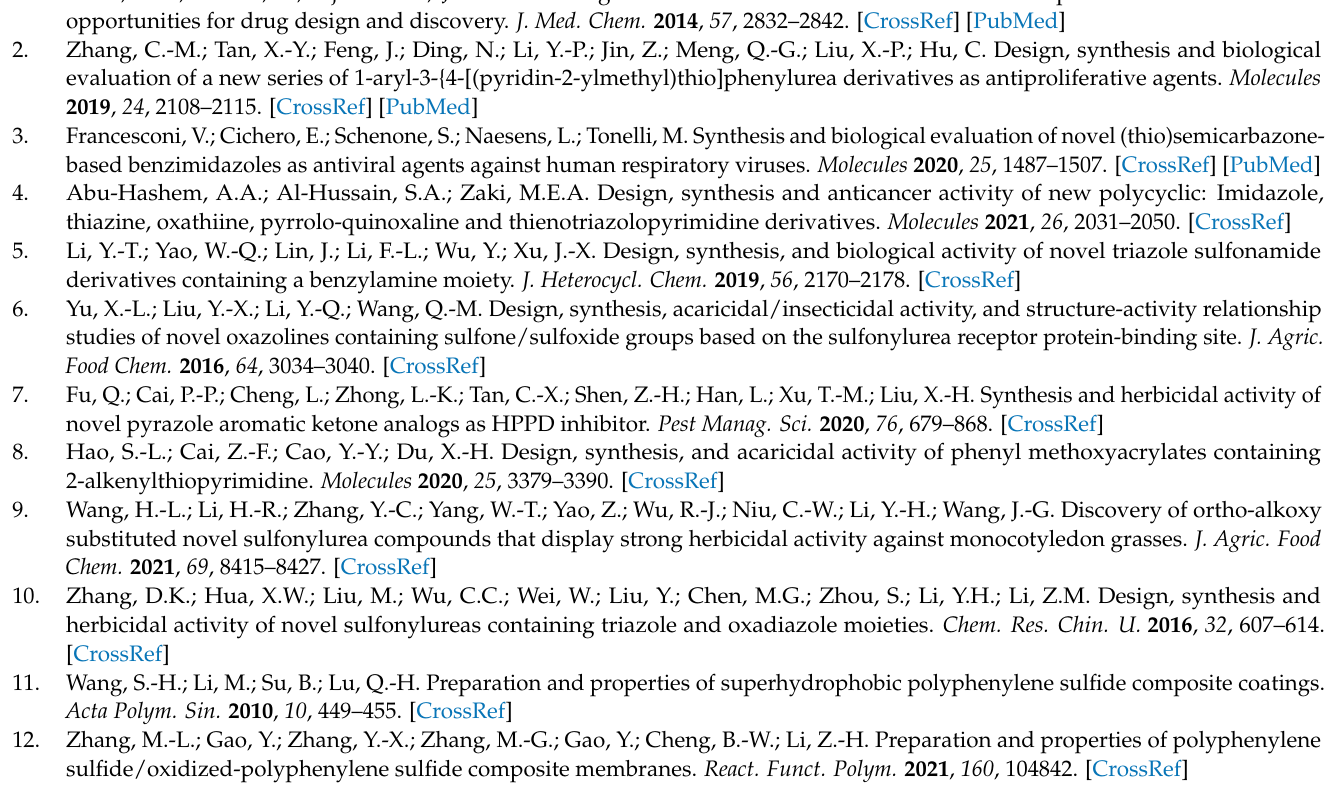
finement parameters of compound 5a ; Table S2: Bond angles of compound 5a ; Table S3: Atomic coordinates ( × 10 4 ) and equivalent isotropic displacement parameters (Å 2 × 10 3 ) of the nonhydrogen atoms; Table S4: Hydrogen coordinates ( × 10 4 ) and isotropic displacement parameters (Å 2 × 10 3 ); Table S5: Bond lengths of compound 5a ; Figure S1–S36: 1 H NMR and 13 C NMR spectra of target compounds 5a-5f , 6a-6f , and